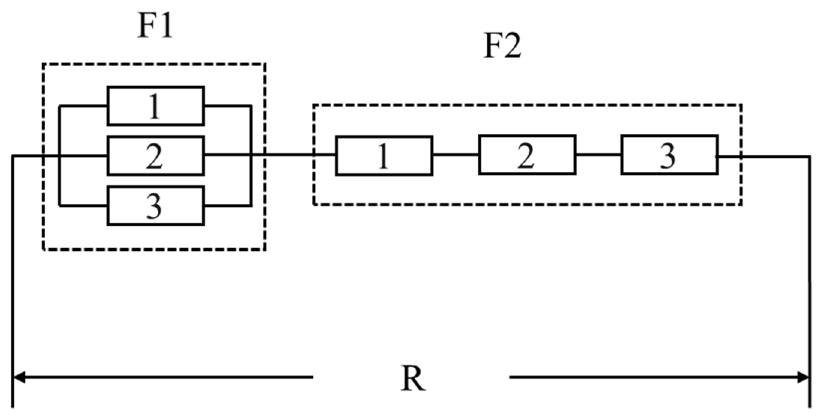
Figure 21. The model of three-component automatic hybrid conduction. Different numbers represent different forms of conductivity. The number 1 represents the conductivity of free pore water in macropores, the number 2 represents the conductivity of wetted film in mesopores, and the number 3 represents the conductivity of micropore water.